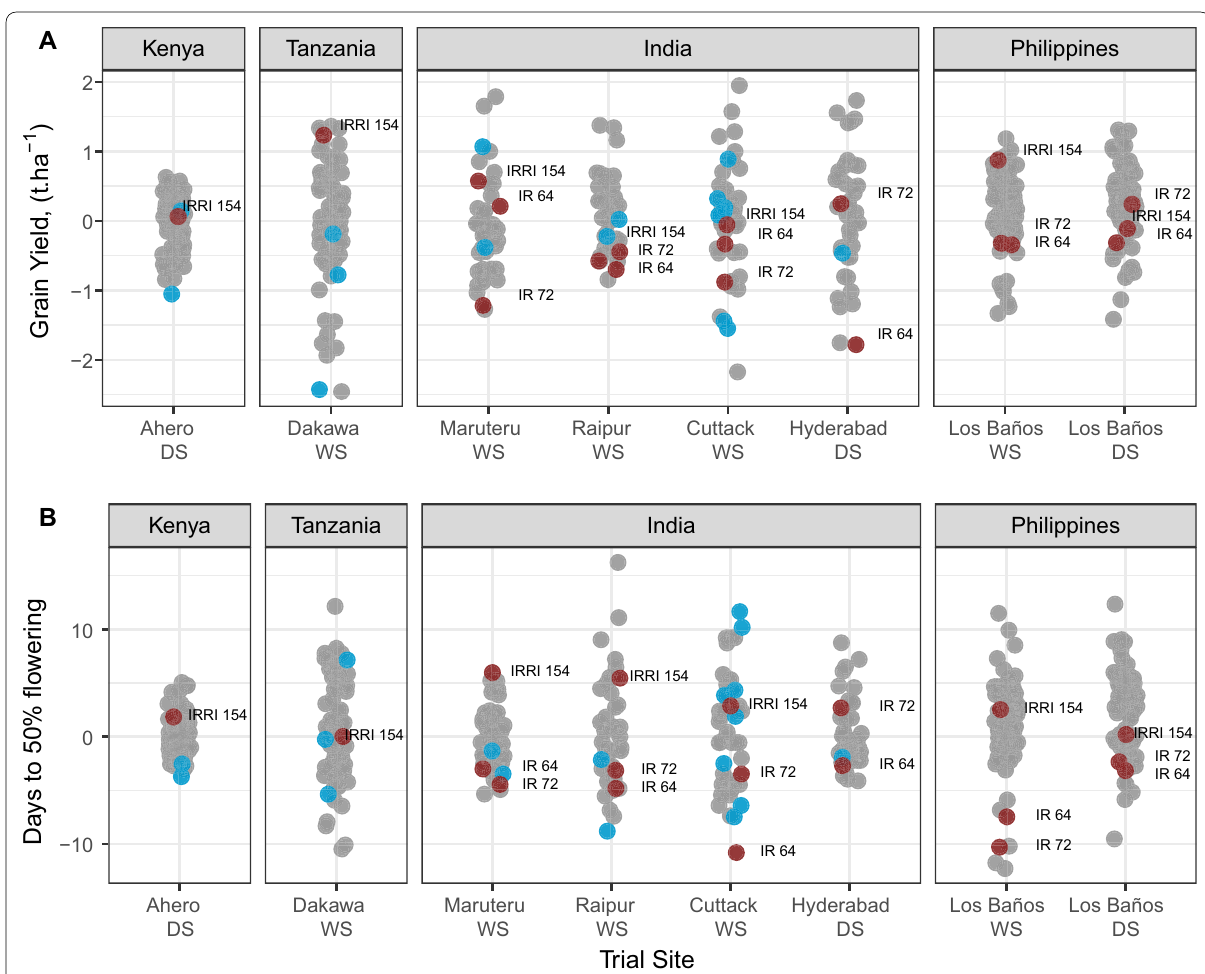
Fig. 8 Agronomic performance of the elite core panel in multi-location field evaluations. The panel A shows the distribution of the best linear unbiased predictor (BLUP) for grain yield and the panel B shows the distribution of BLUPs for days to flowering. The BLUP values are computed for all entries in each field trial using a linear mixed model (see “Materials and Methods” section). The lines composing the core panel are in grey, local and global checks are represented in blue and red, respectively. The name of global checks is displayed next to its BLUP value. The season (WS: wet season or DS: dry season) is also provided along with the